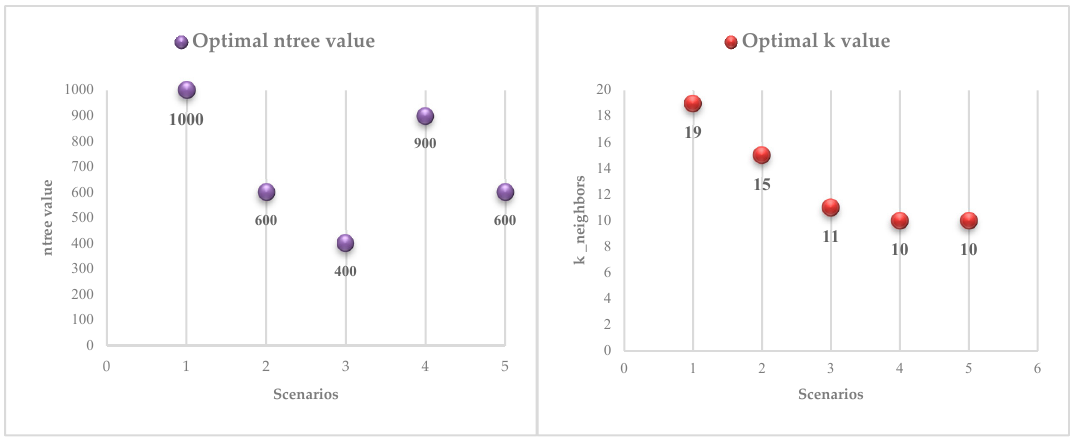
Figure 9. Optimal ntree value of RF ( left ) and optimal k value of KNN in five scenarios ( right ).